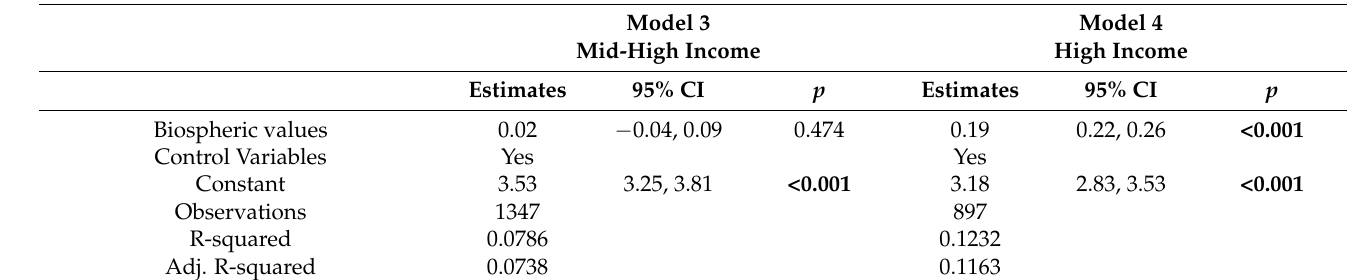
Table 6. Moderating effect of age on the relationship between altruistic values and attitudes.